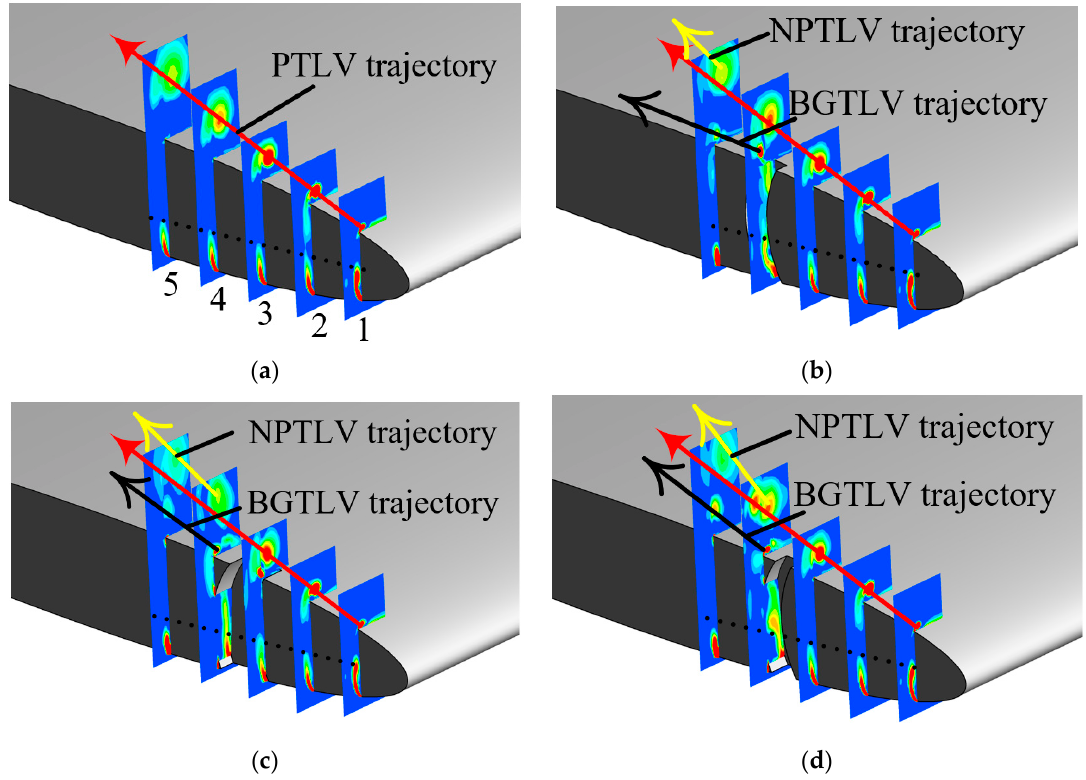
Figure 10. Velocity swirling strength contour on different planes. ( a ) Origin Case, ( b ) Case A, ( c ) Case B, ( d ) Case C.